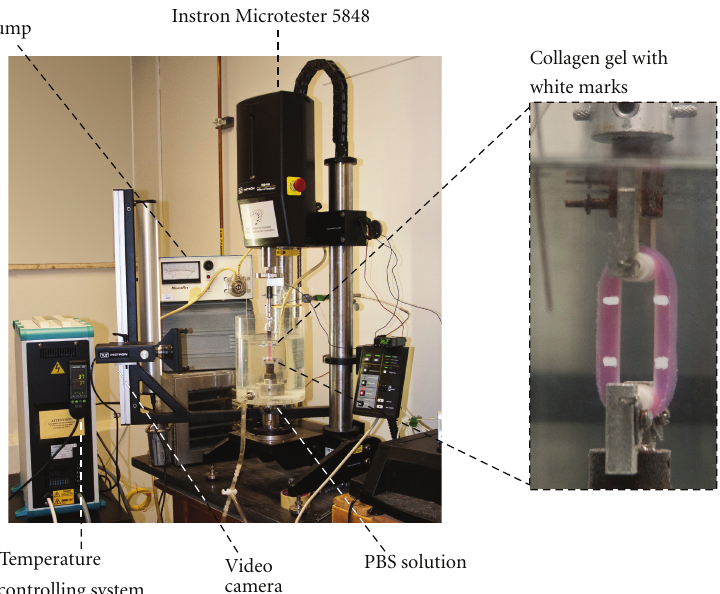
Figure 1: Experimental setup for tensile and relaxation tests on collagen gels. White marks were applied on the gels in order to observe the strain of the sample during